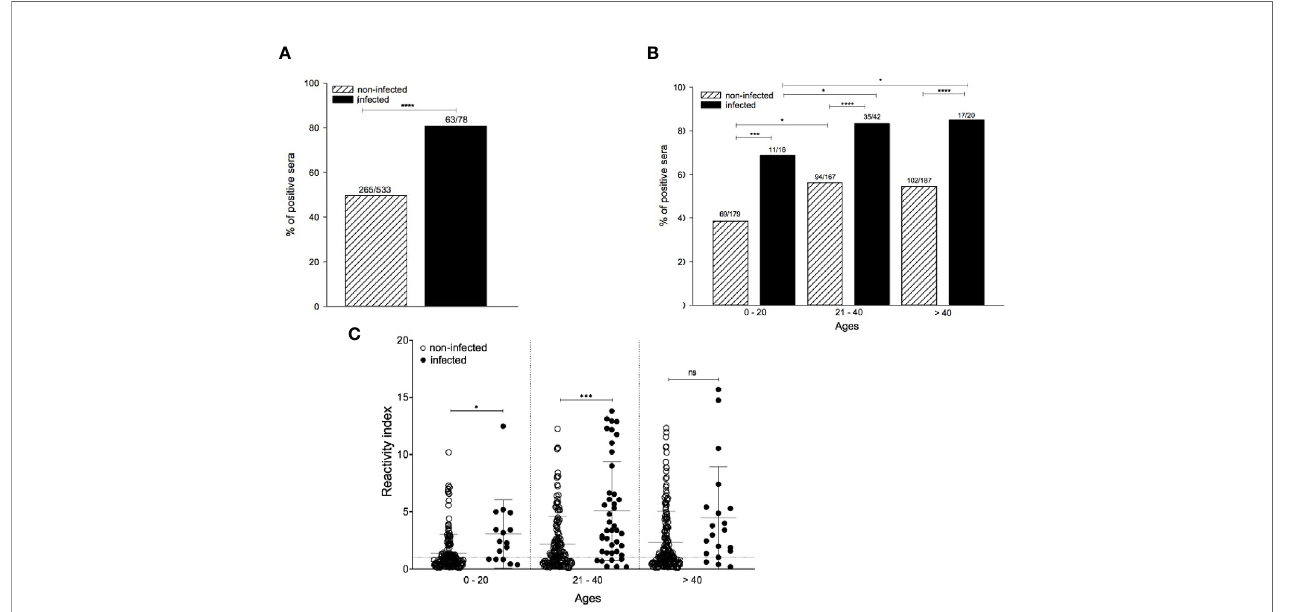
FIGURE 3 | Comparison of the anti-PvAMA-1 Belem IgG response in infected and noninfected individuals naturally exposed to malaria. Serum samples from 611 individuals were grouped into i) infected at the moment of collection (n=78) and ii) noninfected at the moment of collection (n=533). The samples were analyzed for the presence of IgG antibodies against the protein PvAMA-1 Belem through ELISA. The diagnosis of infected individuals was performed using the thick smears technique in the act of collection. The cutoff value (0.125) was calculated using 20 sera from individuals from the city of São Paulo who had never been exposed to malaria. (A) Percentage of positive sera against the Belem variant. **** p < 0.0001. (B) Percentage of positive individuals whose antibodies recognized the Belem variant by age (0 - 20 years, 21 - 40 years or >40 years). * p < 0.05, *** p < 0.001, **** p < 0.0001. (C) Reactivity index (RI) in individuals against the Belem variant grouped by age. The dotted line represents RI equal to 1. The horizontal lack lines over the symbols indicate the median with a 95% con fi dence interval. ns, non signi fi cant; p > 0.05, * p < 0.05, *** p <